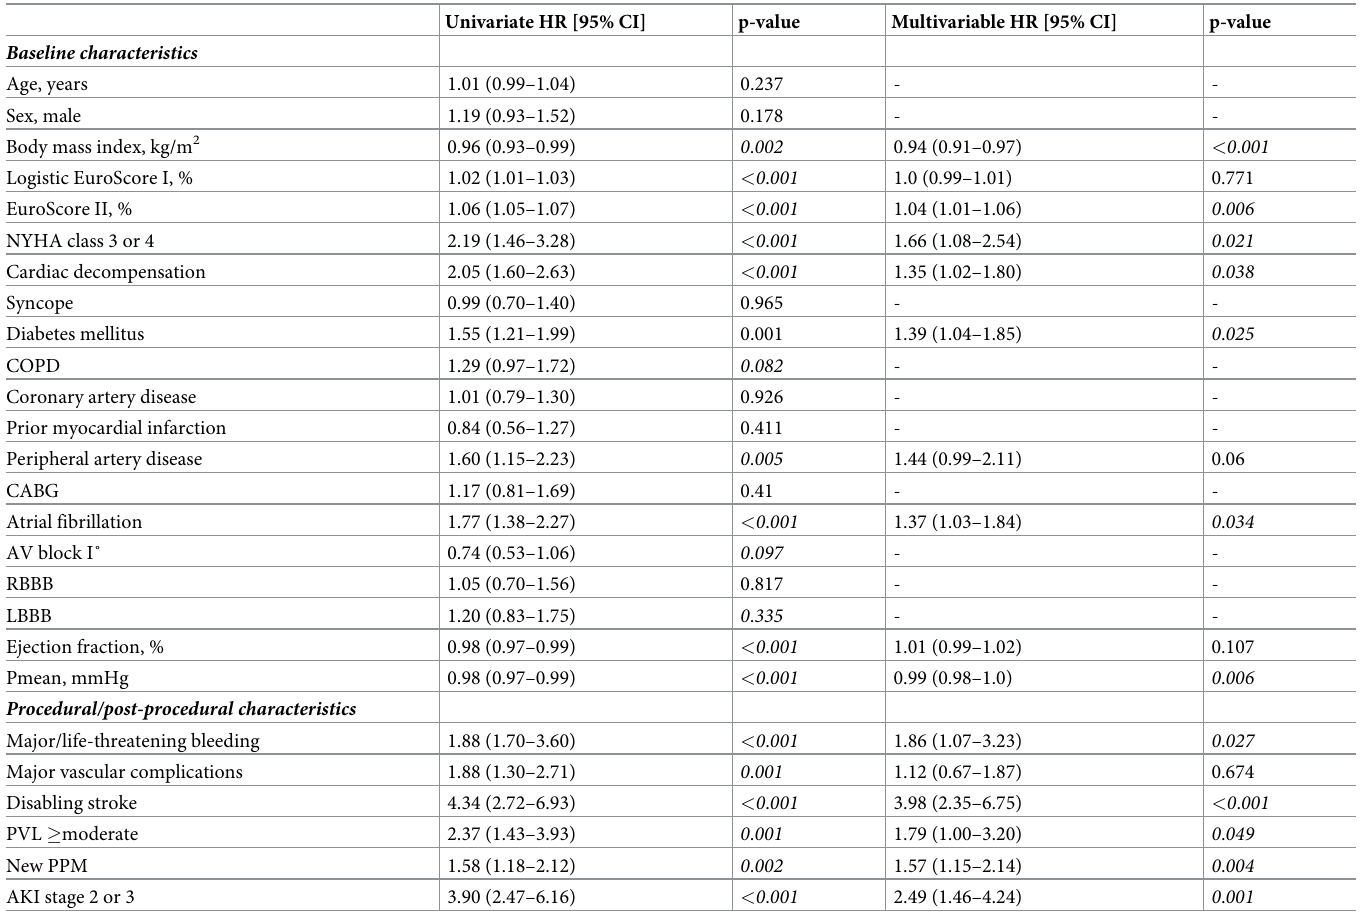
Table 3. Univariate and multivariable predictors of 1-year all-cause